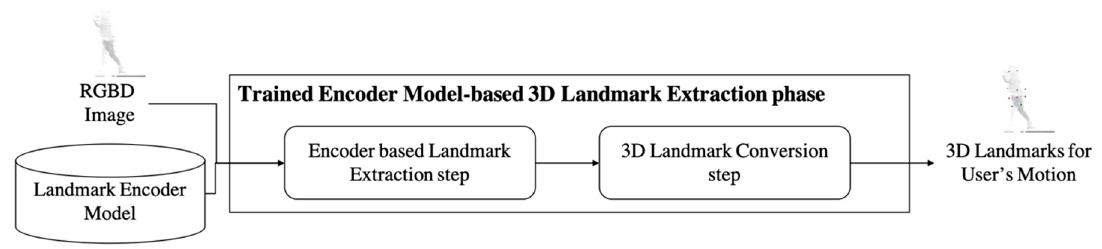
Figure 6. 3D landmark extraction process of RGBD image using trained encoder.